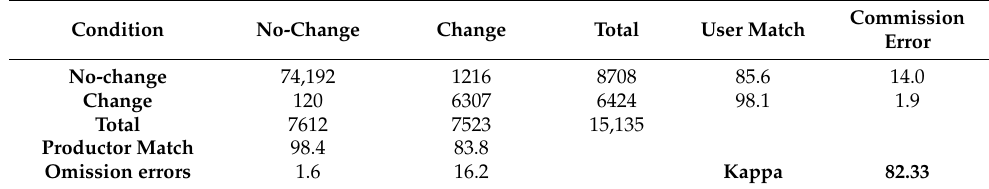
Table 3. Confusion matrix of the change thematic map compared with the Change/No-change